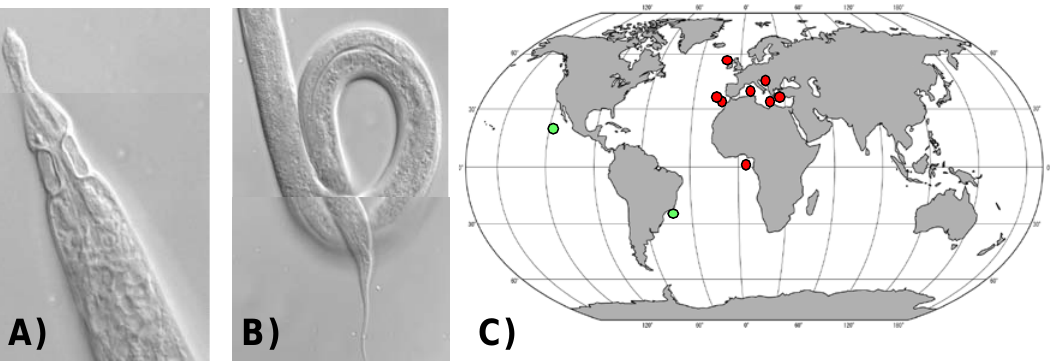
Figure 3. Pictorial key for Manganonema pitilica ( A–C ) , Manganonema robustus ( D–F ) and Manganonema bussuaensis ( G–I ) with the representation of the anterior and posterior ends, geographical distribution (red circles indicate records in the present study, green circles indicate records available in literature) and short diagnosis of each species. Reported are ratio a = body length divided by maximum body diameter, b = body length divided by pharyngeal length, c = body length divided by tail length, c' = tail length divided by anal body diameter, cbd = corresponding body